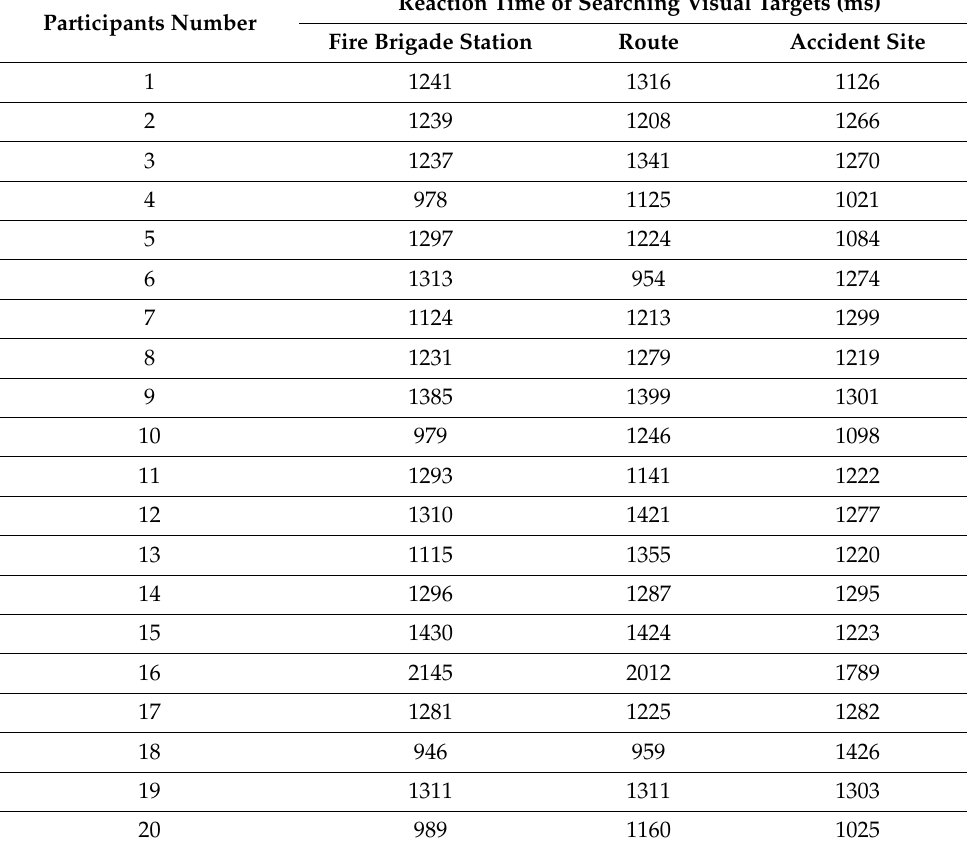
Table A1. The Reaction Time of Group A (Figure 4a map).